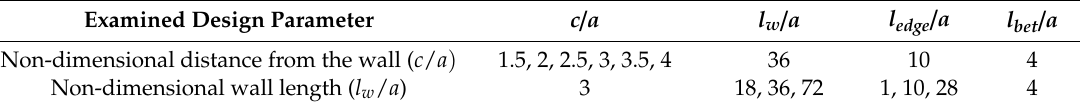
Table 2. Examined cases for the array of the five semi-immersed oblate spheroidal WECs. Examined Design Parameter 𝒄/𝒂 𝒍 𝒘 /𝒂 𝒍 𝒆𝒅𝒈𝒆 /𝒂 𝒍 𝒃𝒆𝒕 /𝒂 Non-dimensional distance from the wall ( 𝑐/𝑎) 1.5 , 2 , 2.5 , 3 , 3.5 , 4 Non-dimensional wall length ( 𝑙 (cid:3050) /𝑎 )